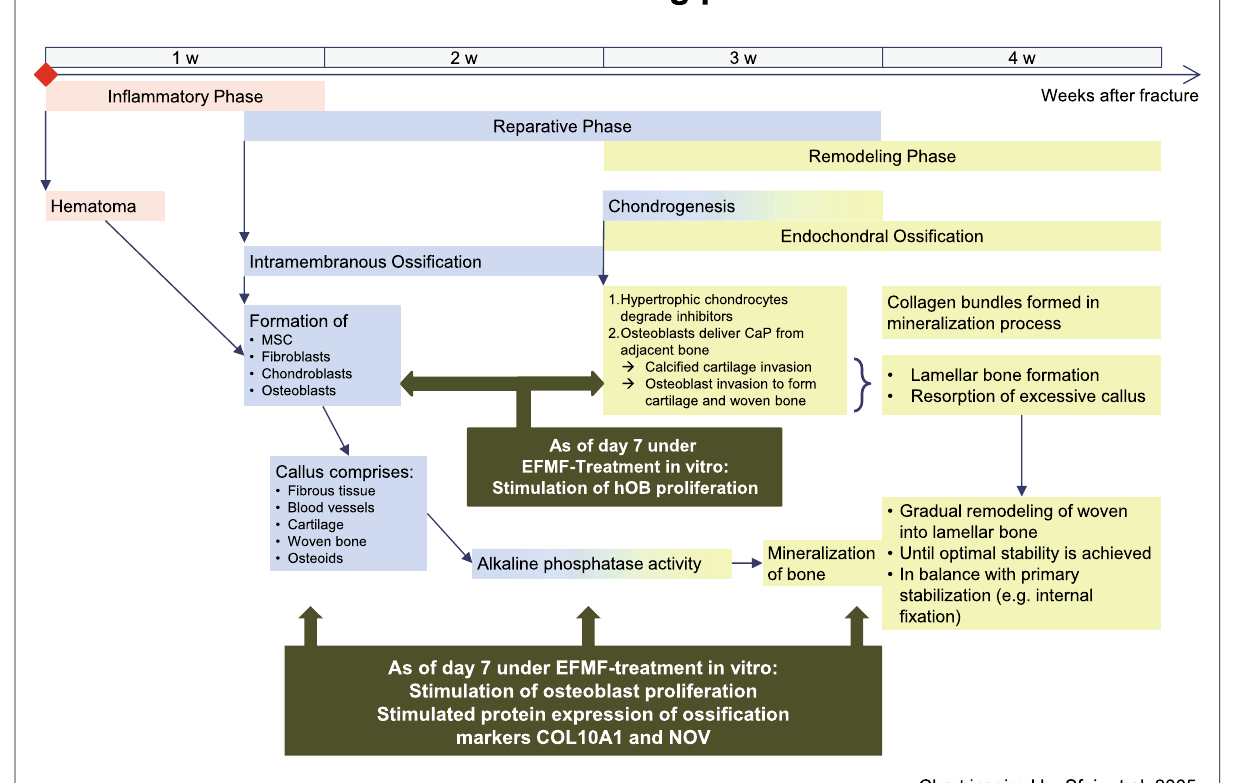
Fig. 7 Cellular and physiological processes relevant for bone fracture repair. The expression of osteogenic proteins such as COL10A1 and NOV is stimulated after day 7, supporting alkaline phosphatase activity. hOB is stimulated when the endochondral ossification phase starts, and cartilage is remodeled into woven bone. The results are illustrated as a graphic representation of the bone healing process according to Sfeir [44]. However, the illustration purposefully focuses on the first four weeks after fracture, although the bone remodeling process